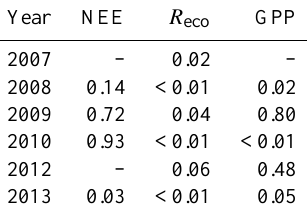
Table 3. Results ( p value) of 1-way analysis of variance (ANOVA) on daily GPP, R eco and NEE with respect to 10 water table depth (WTD) classes (>0 to < − 45cm in increments of 5cm). Missing values denote failure of the equal variance